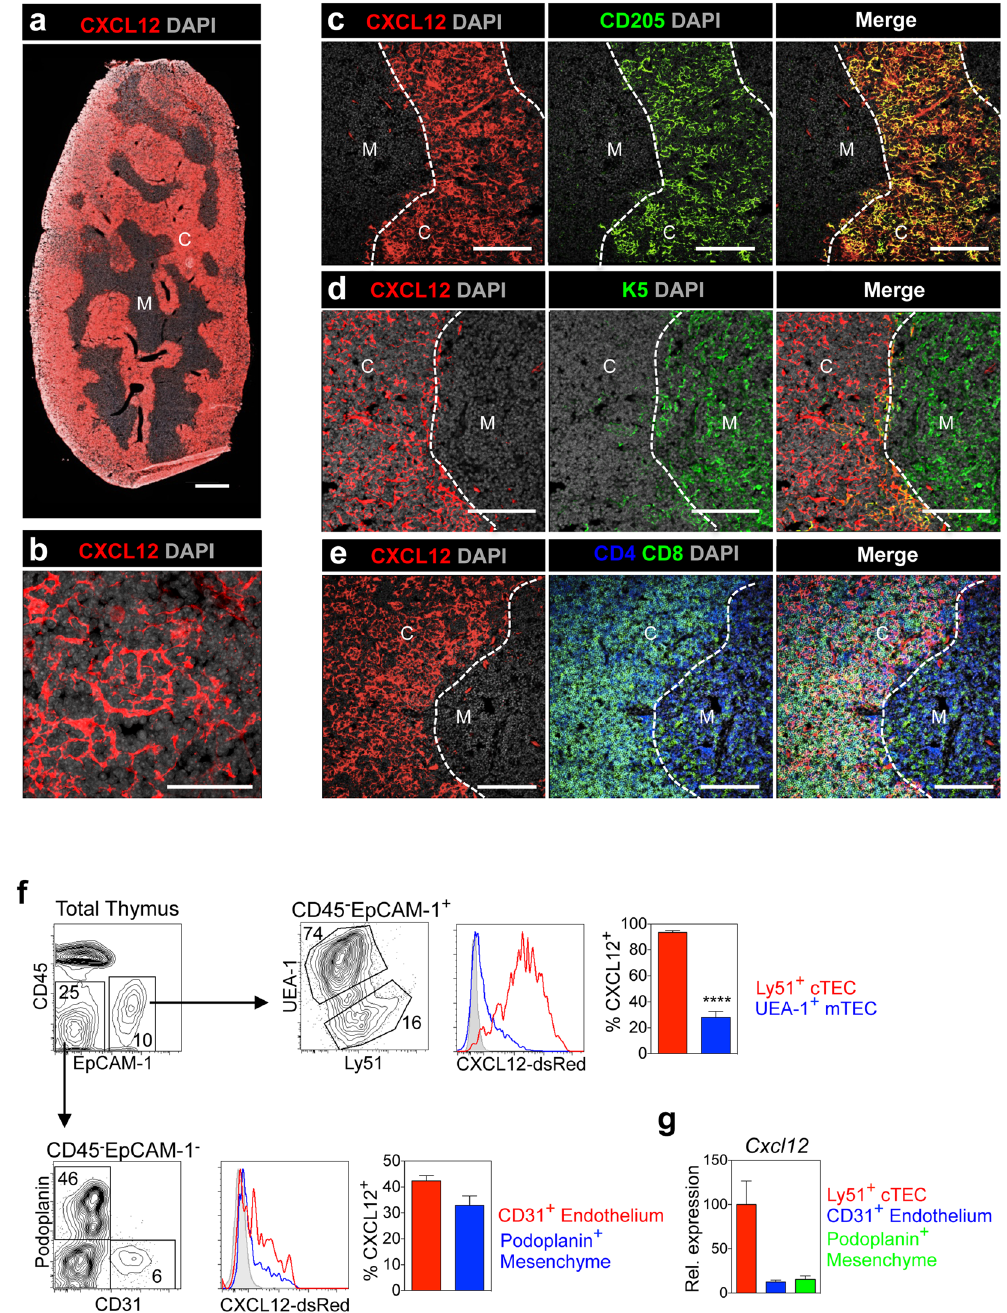
Figure 1. CXCL12 Is Expressed Throughout The Thymic Cortex. Confocal images showing ( a) expression of CXCL12 dsRed in the thymus, scale bar represents 500 μ m ( b) reticular morphology of CXCL12 dsRed expressing cells, scale bar represents 50 μ m ( c ) co-localisation of CXCL12 dsRed + cells and CD205 + cTEC, ( d) absence of CXCL12 dsRed expression by K5 + mTEC, ( e) restriction of CXCL12 dsRed + cells to areas of the thymus containing CD4 + CD8 + DP thymocytes. ‘C’ denotes cortex and ‘M’ denotes medulla, confocal images are representative of at least three mice. Scale bars in b-d represent 100 μ m. ( f) Representative FACS analysis and quantitation of CXCL12 dsRed expression by UEA-1 + EpCAM-1 + mTEC and Ly51 + EpCAM-1 + cTEC, CD31 + endothelium and podoplanin + mesenchyme. n > 5, unpaired Student’s t test **** p < 0.0001. ( g) Purified thymic stromal cells from WT mice were analyzed by qPCR for Cxcl12 mRNA, normalized to β -actin (mean ± SEM). qPCR data is representative of at least two independent biological experiments. Error bars represent